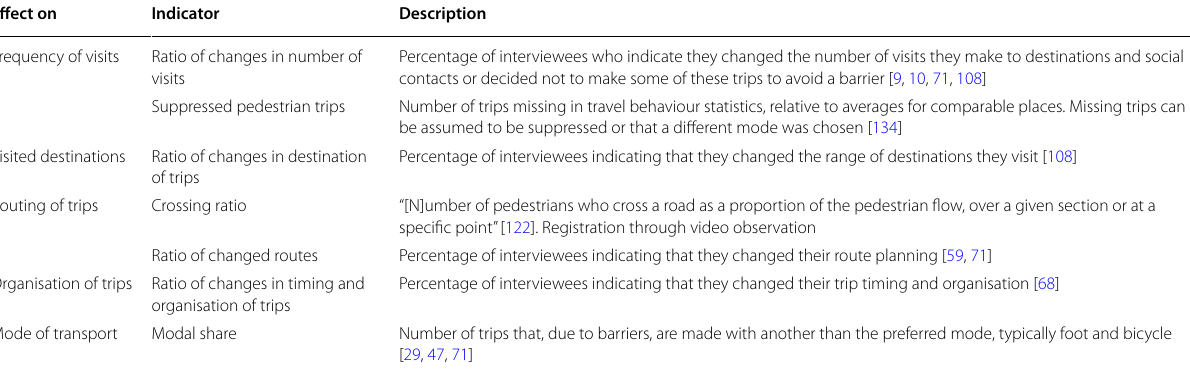
Table 9 Indicators of indirect barrier effects Effect on Indicator Description Frequency of